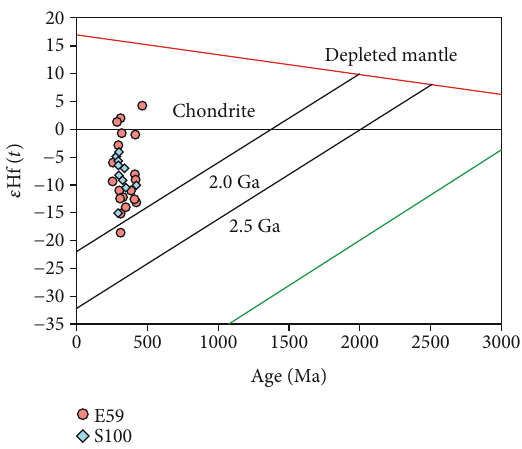
Figure 4: Plots of ε Hf ð t Þ versus 207 Pb/ 206 Pb ages of all detrital zircons of the study